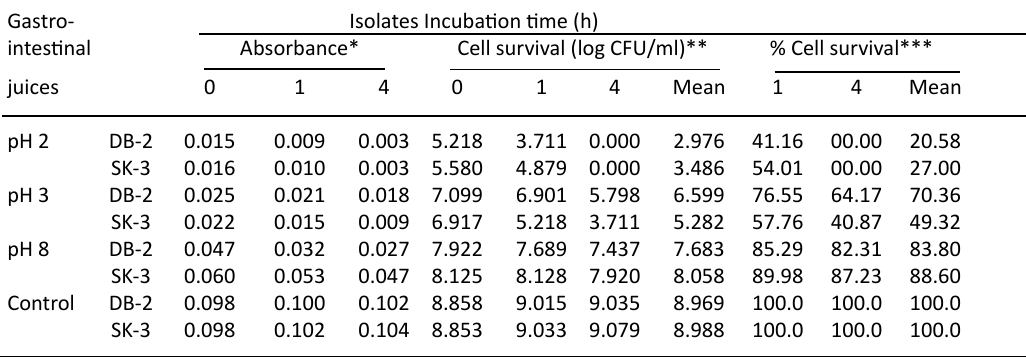
Aggregation property Autoaggregation Interaction of the bacterial strain with itself (clumping of the cell) determines the auto- aggregation capability. Probiotic bacteria should